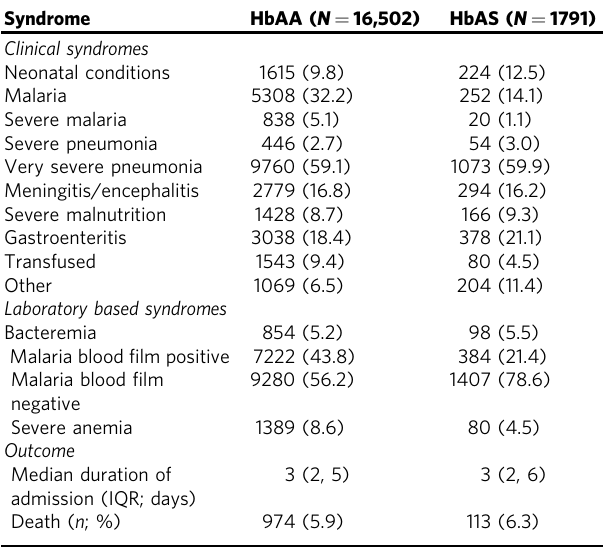
Table 2 Distribution of clinical syndromes and outcomes among case-children Syndrome HbAA ( N = 16,502) HbAS ( N = 1791) Clinical syndromes Neonatal